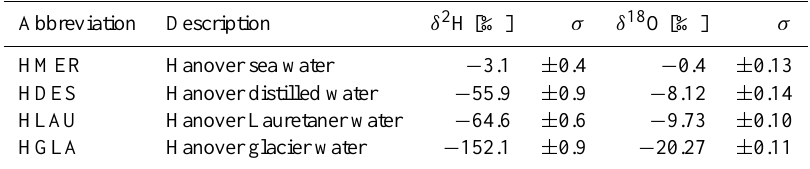
Table 1. Standards used for normalization, drift correction, and quality check. The standards are used for both the measurements with the in situ approach in the field and the extracted soil water in the laboratory.